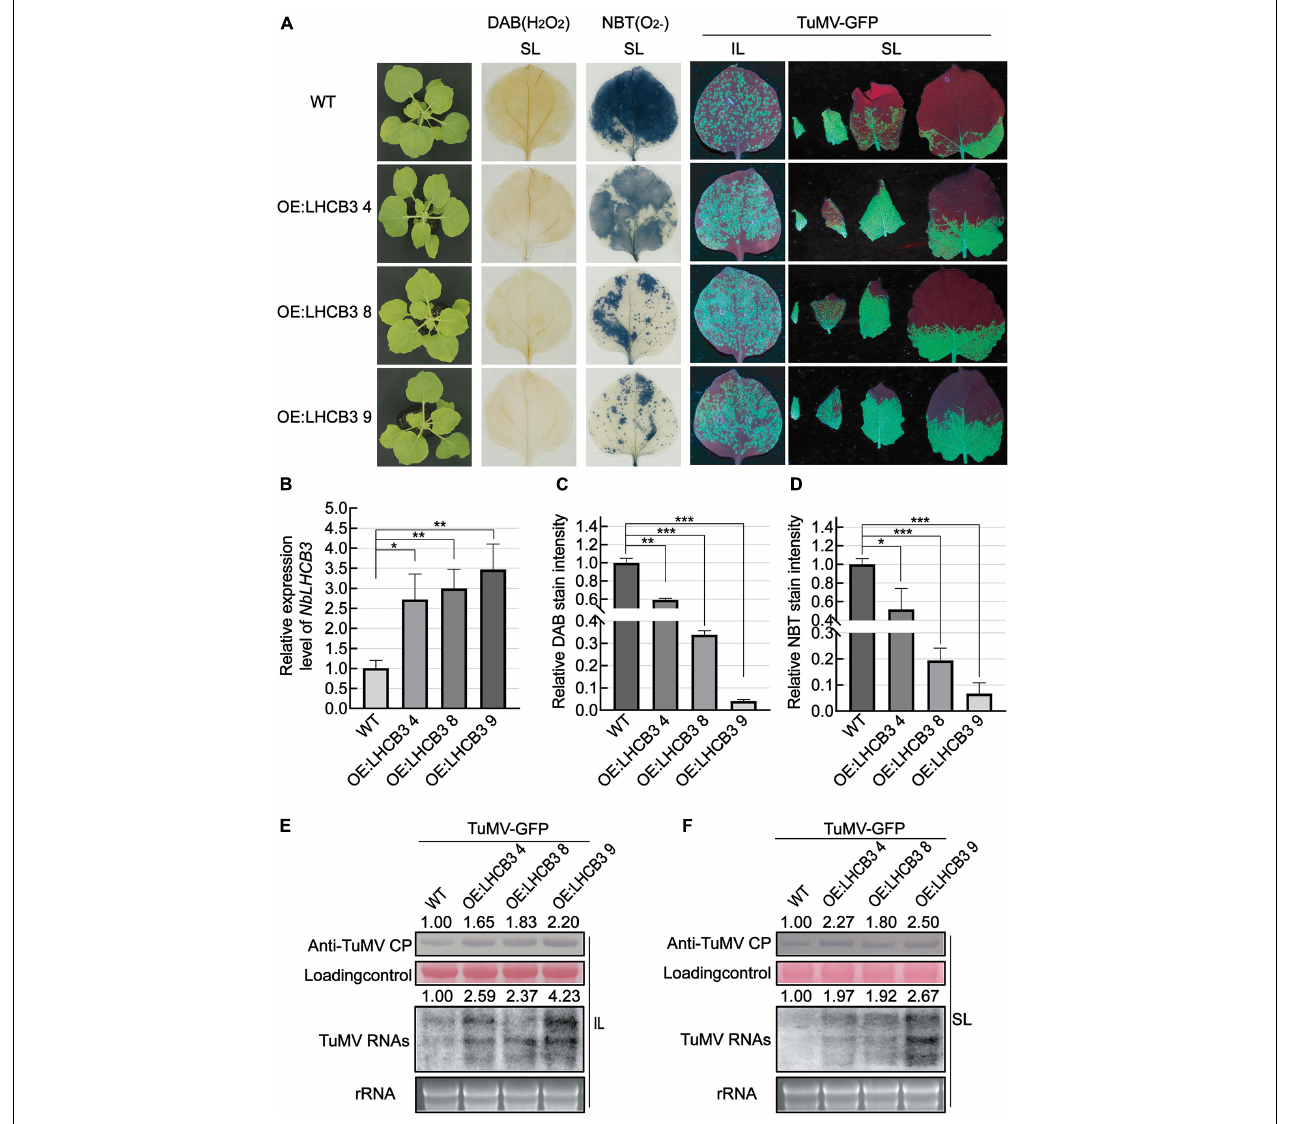
FIGURE 6 | Overexpression of NbLHCB3 in N. benthamiana increased the accumulation of TuMV RNAs and CP. (A) The phenotype of plants under bright light is shown at the left. DAB and NBT staining show less ROS accumulation in the transgenic plants. Fluorescence arising from TuMV-GFP infection on three transgenic lines and wild type (WT) plants: IL and SL were photographed at 5 dpi under UV light. (B) qRT-PCR assay of expression of NbLHCB3 in these three transgenic lines compared to WT. (C) The relative DAB stain intensity in these three transgenic lines compared with WT calculated by IMAGE J software. (D) The relative NBT stain intensity in these three transgenic lines compared with WT calculated by IMAGE J software. (E,F) Accumulation of TuMV RNAs and CP in IL (E) and SL (F) . The relative intensity of the blot signal quantified by IMAGE J software is shown on the lanes. Bars represent the standard errors of the means from three biological repeats. A two-sample unequal variance directional Student’s t -test was used to test the significance of the differences (* P < 0.05; ** P < 0.01; *** P <